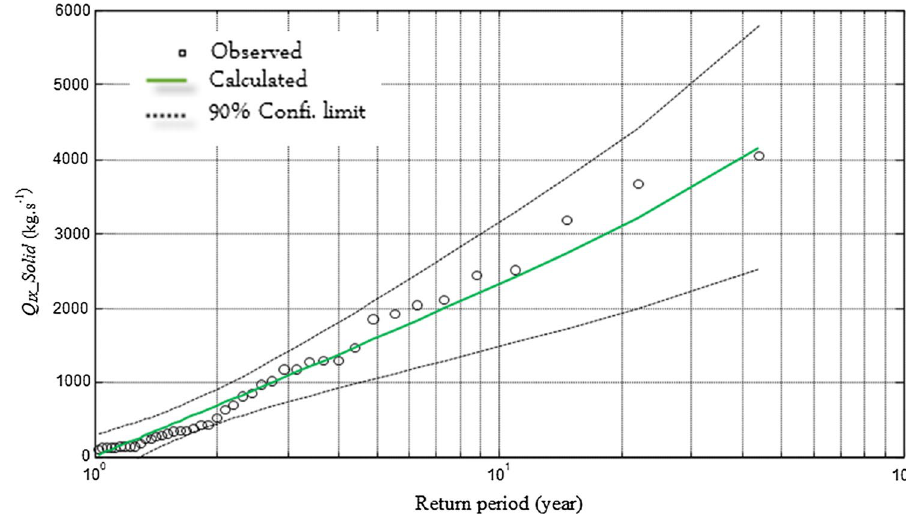
Fig. 7 Fitting and confidence limits at 95% of the QIX_solid series to the exponential distri-